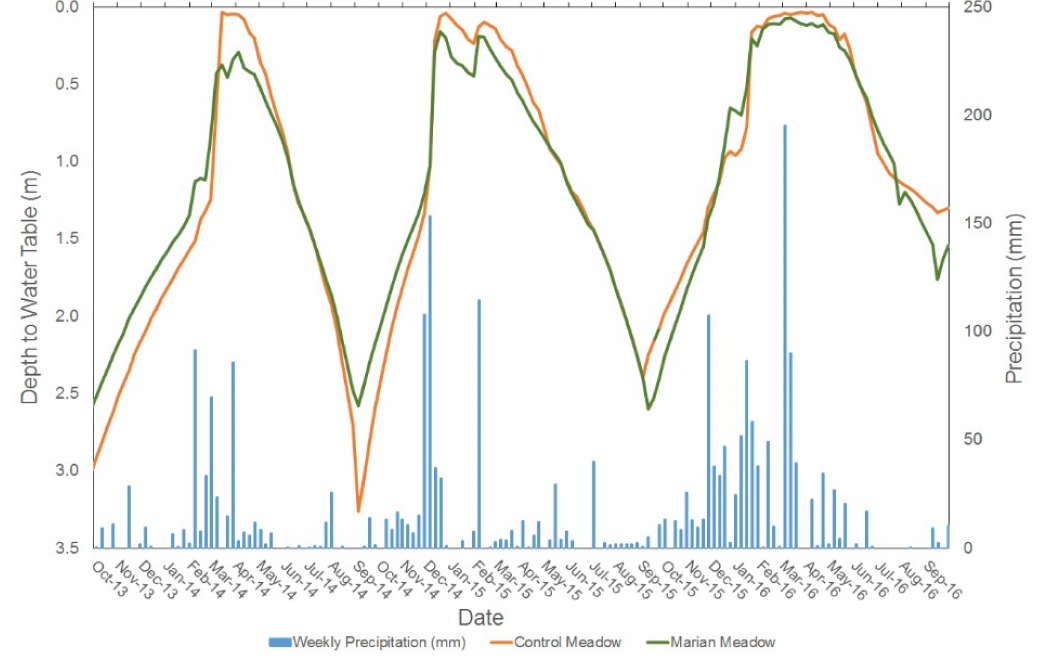
Figure 8. Depth to groundwater (m) and rainfall (mm) for Marian Meadow and the Control